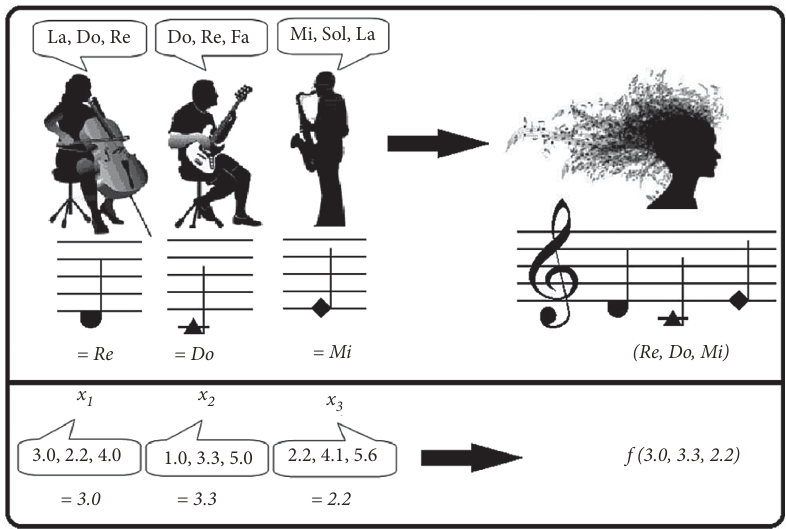
Figure 1: Illustration of the analogy between musical improvisation and optimization concepts [62].